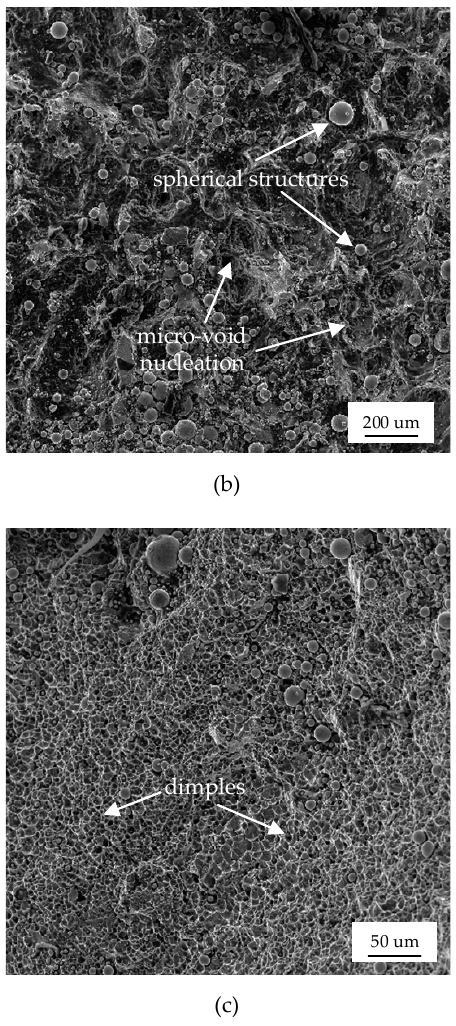
Figure 10. The SEM micro-morphology fracture surface of the SPT specimen: ( a – c ) in Figure 9 correspond to points ( a – c ), respectively.